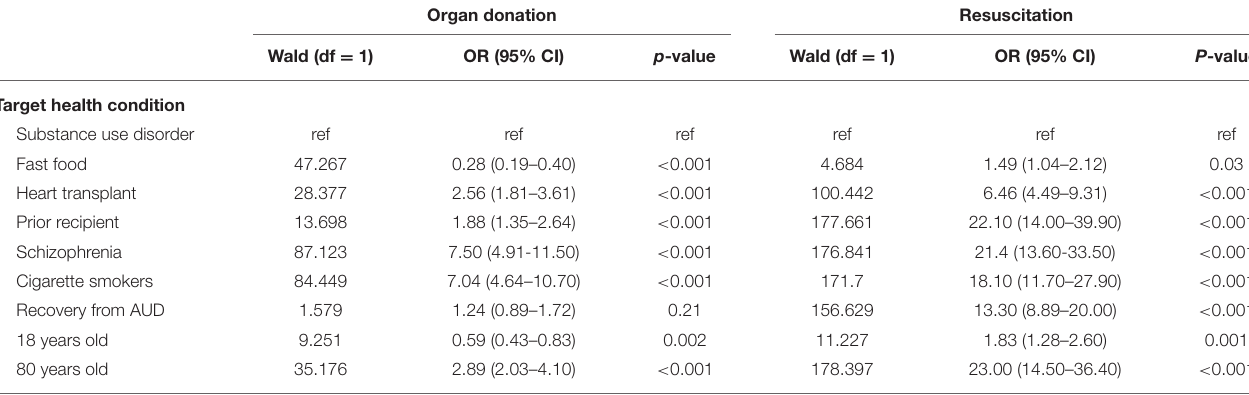
TABLE 2 | Univariate evaluation of stigma as a function of health